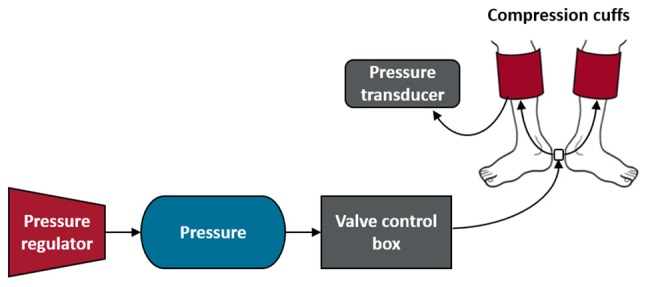
Compression system. The compression system encompassed a pressure regulator, a pressure source, a valve control box and two compression cuffs (adult large), shown above from left to right. The pressure source was connected to a valve control box with an Arduino board and programmable Arduino chip, which allowed us to program the valve system to cycle from open for 4 s to closed for 11 s throughout the test. In addition, the pressure inside one of the compression cuffs was continuously monitored throughout testing with the use of a pressure transducer.